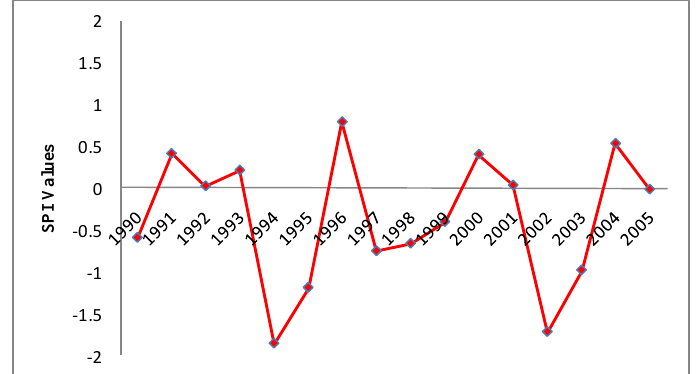
Figure 5. SPI values for first 6-month.